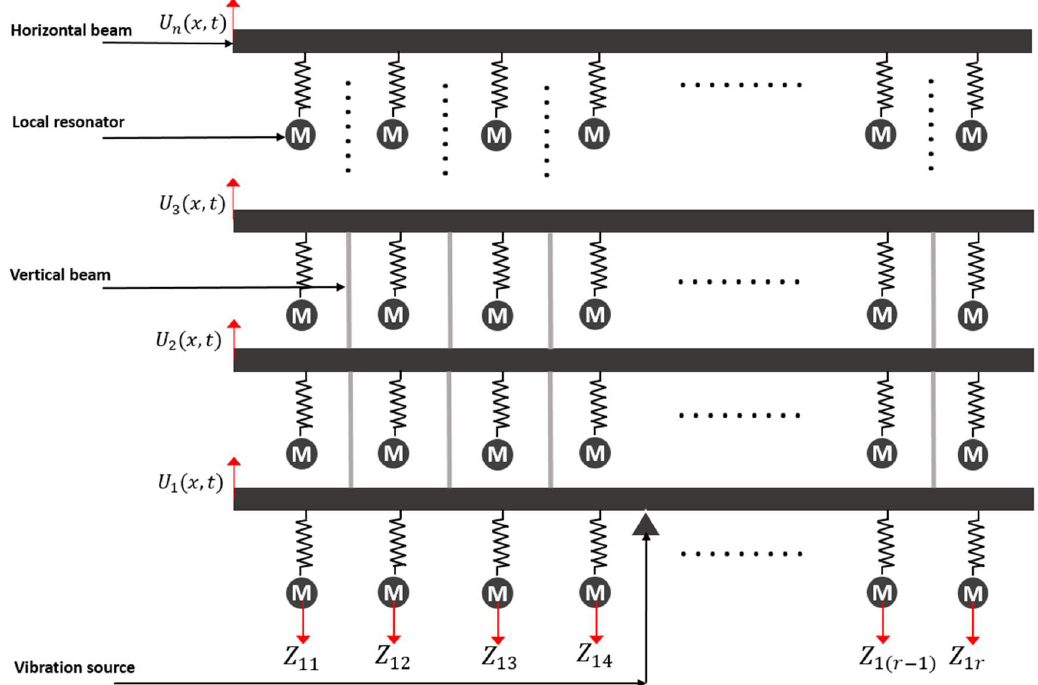
Figure 3. General design approach for an n-layered horizontal beam with r-number of local resonators and vertical beams interlinking the horizontal beams.